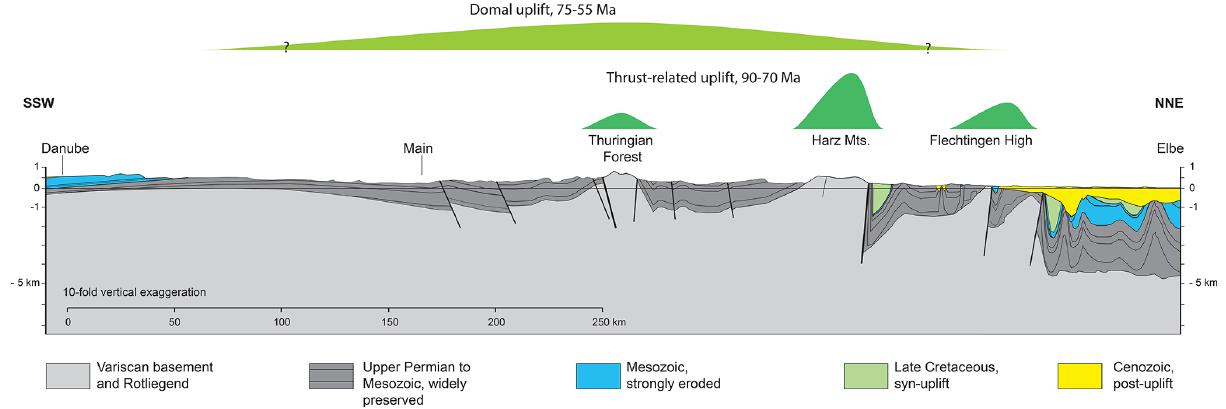
Figure 11. The two superposed uplift and exhumation processes illustrated on the cross section in Fig. 4. Thrust-related uplift confined to three discrete basement blocks is followed, possibly with some temporal overlap, by domal uplift persisting into the Paleogene. Uplift and exhumation magnitudes are not to